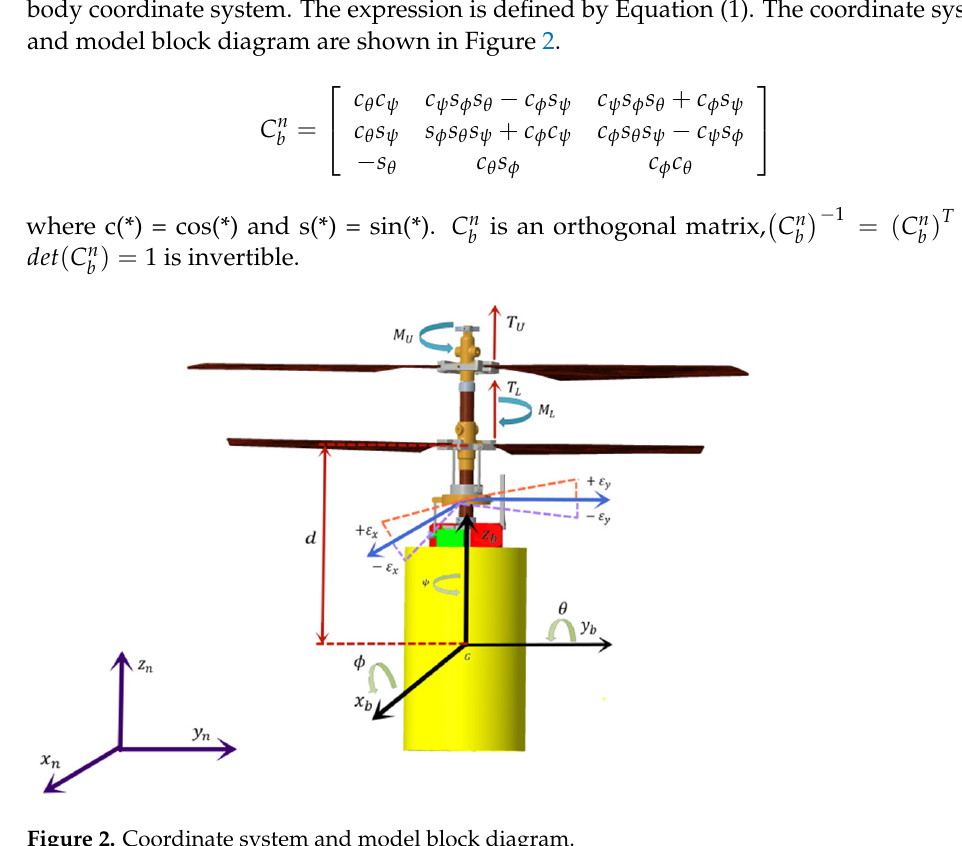
Figure 2. Coordinate system and model block diagram. According to the kinematics equation of position translation, the velocity of a rigid body corresponds to the time derivative of the center of gravity in the navigation coordinate system. The expression is defined by Equation